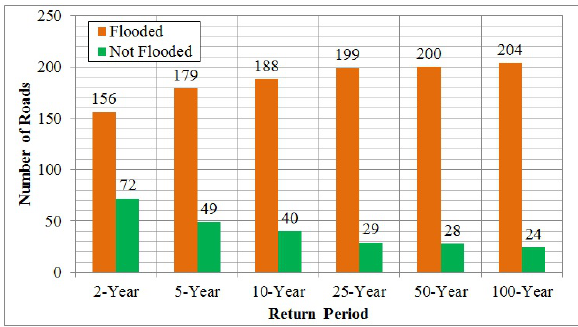
Figure 10: Number of affected roads for each of the 6 extreme rainfall events.